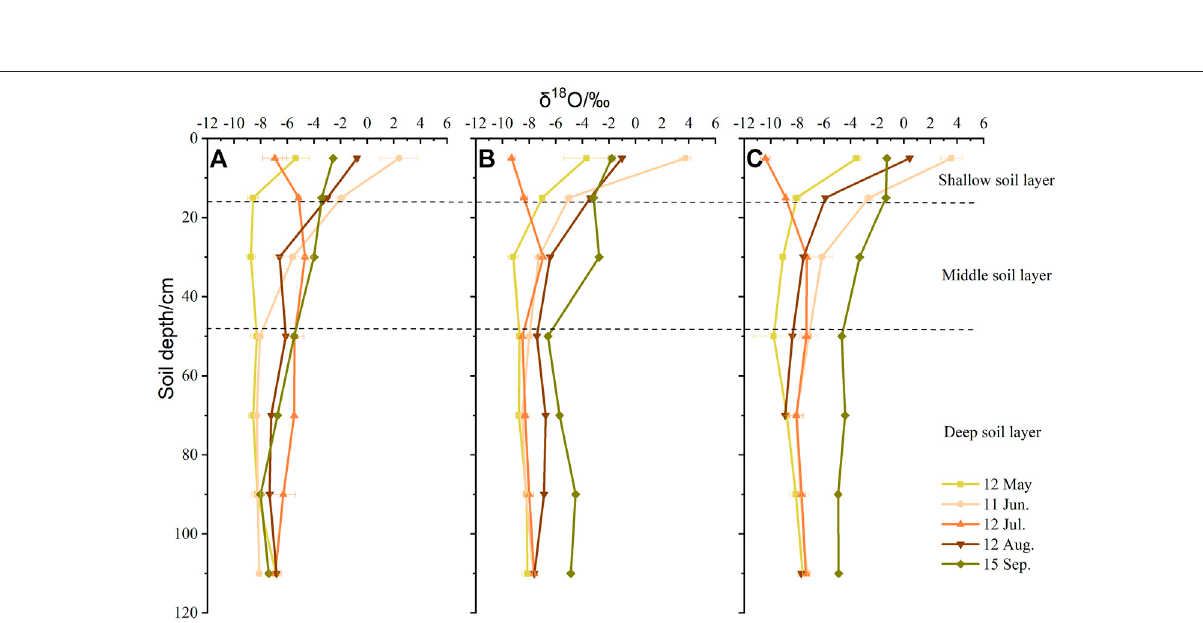
Frontiers in Earth Science |